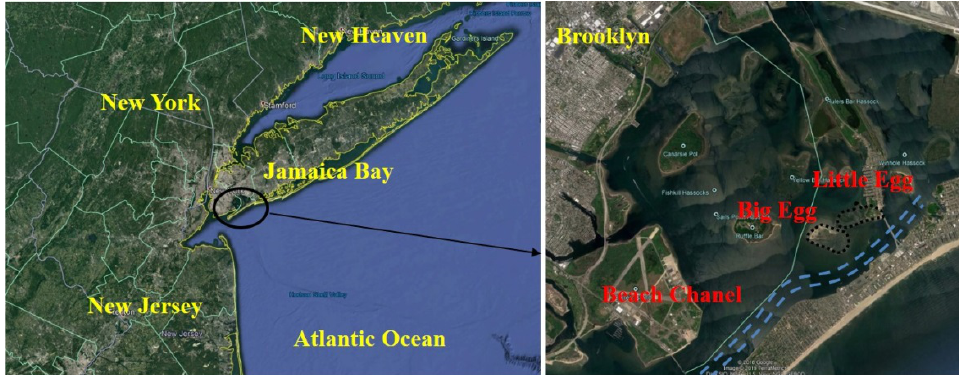
Figure 1. Geographic locations of Jamaica Bay (left panel) and Big and Little Egg marsh islands (Right Panel). The blue dashed lines show the navigation route in Beach Channel.